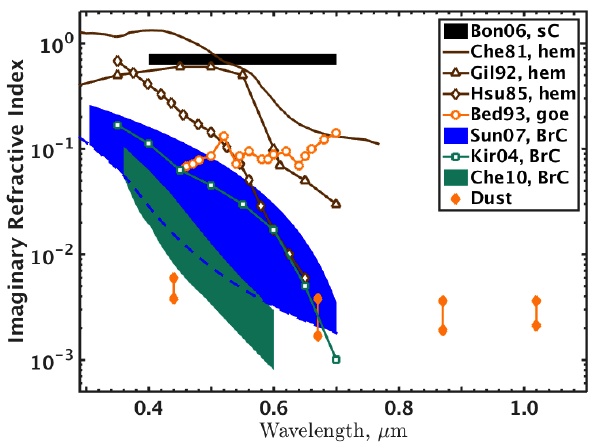
Figure 1. Imaginary refractive index of several absorbing aerosols. Bon06 is soot carbon (Bond and Bergstrom, 2006); Che81 is hematite (Chen and Cahan, 1981); Gil92 is hematite (Gillespie and Lindberg, 1992); Hsu85 is hematite (Hsu and Matijevi´c, 1985); Bed93 is goethite (Bedidi and Cervelle, 1993); Sun07 is brown car- bon (Sun et al., 2007); Kir04 is brown carbon (Kirchstetter et al., 2004); Che10 is brown carbon (Chen and Bond, 2010); Dust is the range of AERONET dust climatologies over Africa and the Middle